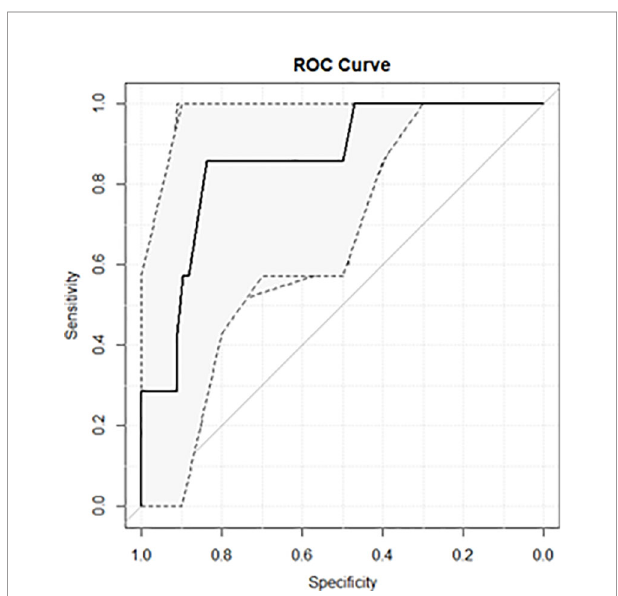
FIGURE 3 | ROC curve of the predictive model focused on identifying treatment fractions where a variation higher than − 2% was observed in V95% of PTV.